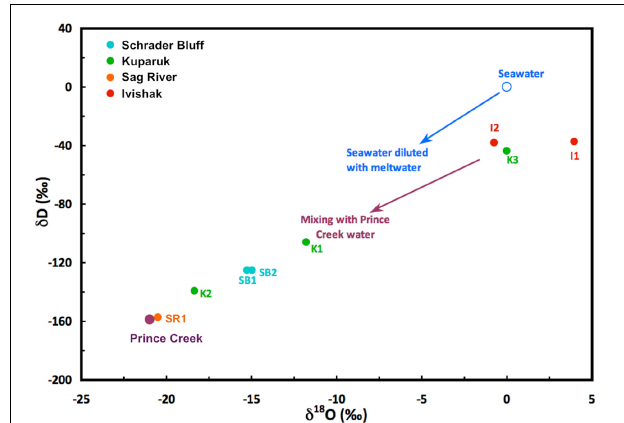
FIGURE 2 | Hydrogen and oxygen isotope compositions of produced water from North Slope wells. Waters consist of a mix of reservoir formation waters, Prince Creek Formation water, and/or seawater that were injected to support oil production. North Slope seawater is strongly influenced by melting sea ice and runoff during the summer